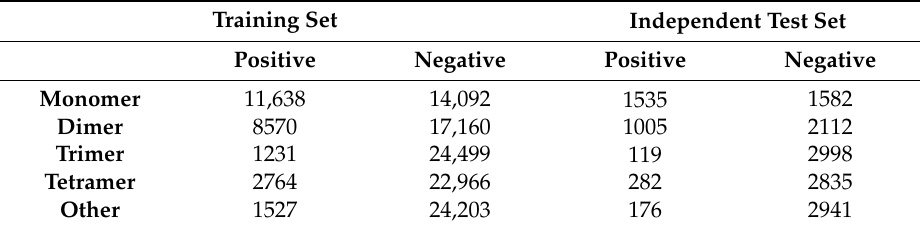
Table 2. Positive and negative data of training set and independent